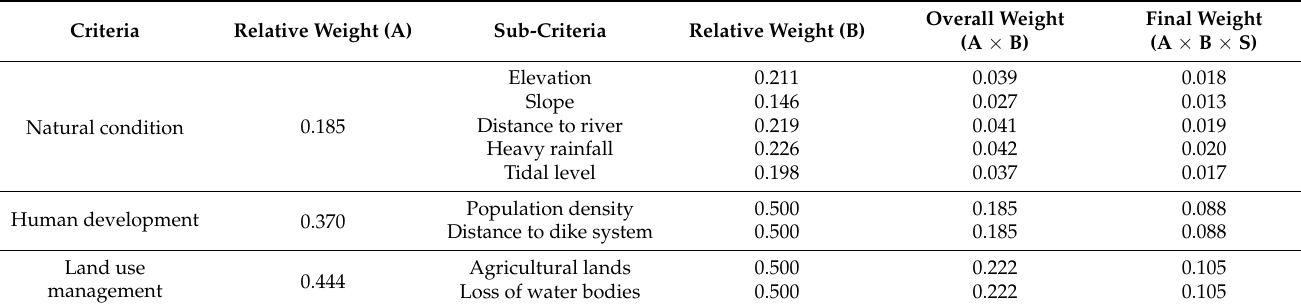
Table 3. The overall weights of the scheme strategy under criteria for the